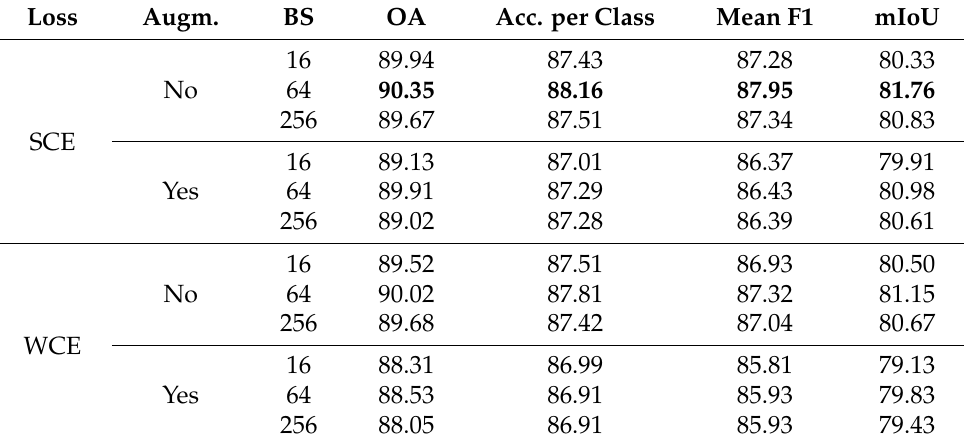
Table 5. Ablation studies investigating losses, augmentations, and batch sizes. The best model is highlighted in